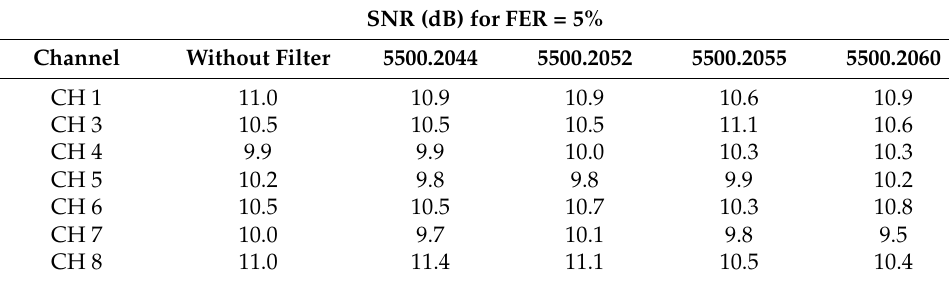
Figure 9. FER-SNR curve on channel 4 for DBPSK without filter and when filters are connected at point C in an open-circuit configuration. Table 7. SNR required for FER = 5% in each signal configuration when filters are not loaded.